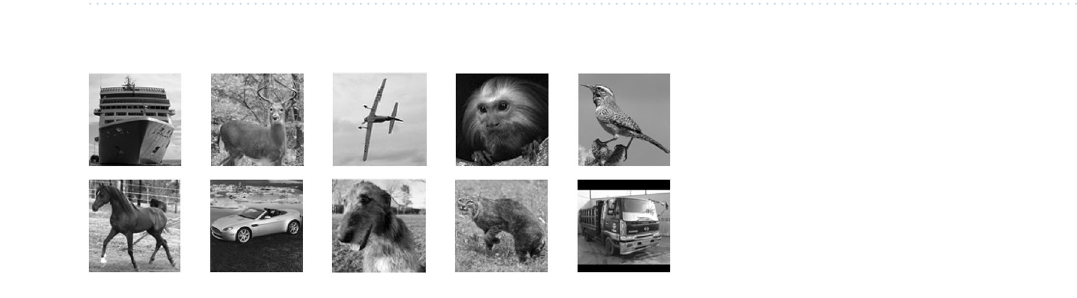
Figure 2. Sample images from 10 classes used for